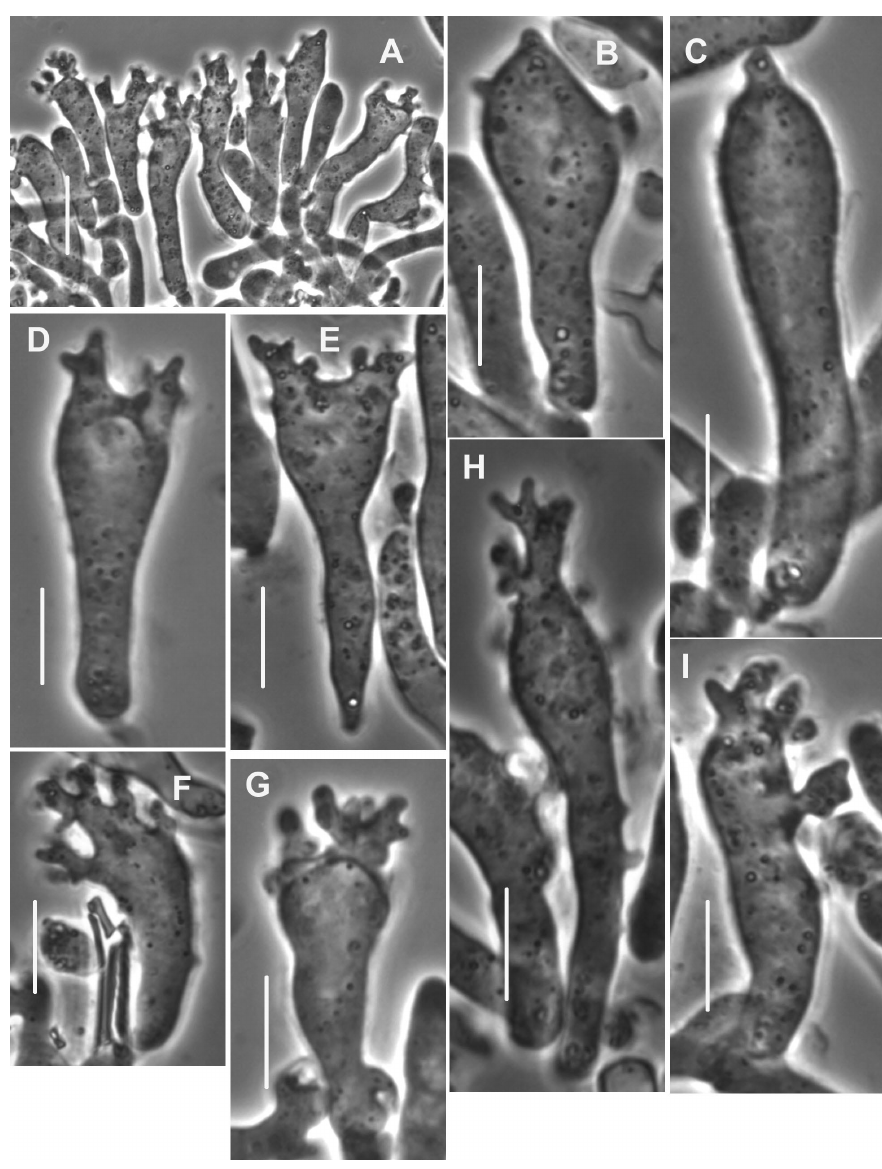
Figure 84. Mycetinis scorodonius f. diminutivus . Cheilocystidia. A Lamellar edge B, C Individuals with rudimentary diverticula D–I Individuals with typical diverticula. Standard bars = 10 µm. WTU 10961-